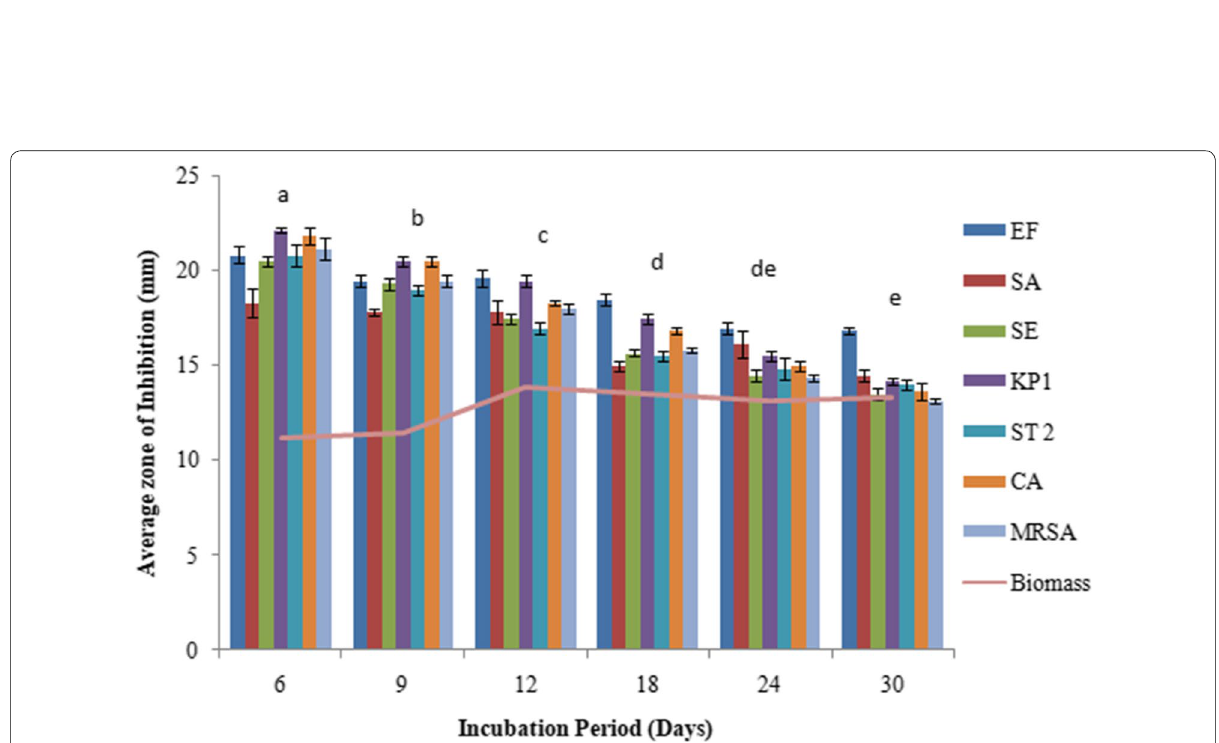
Fig. 3 Effect of different incubation period on antimicrobial activity of C. globosum . EF, Enterococcus faecalis; SA, Staphylococcus aureus ; SE, Staphylococcus epidermidis ; KP1, Klebsiella pneumoniae 1; ST2, Salmonella typhimurium 2; CA, Candida albicans MRSA, Methicillin-resistant Staphylococcus aureus. *Values are given as mean SE. Different letters (a to e) between the columns are significantly different (post hoc tukey Test, ± p ≤